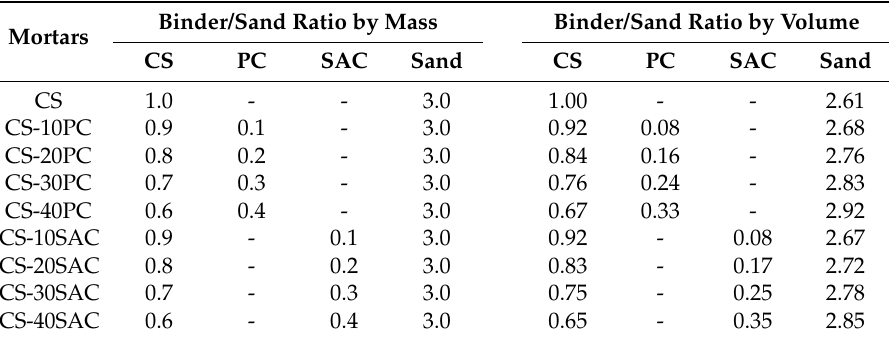
Table 3. Binder/sand ratio of mortars.